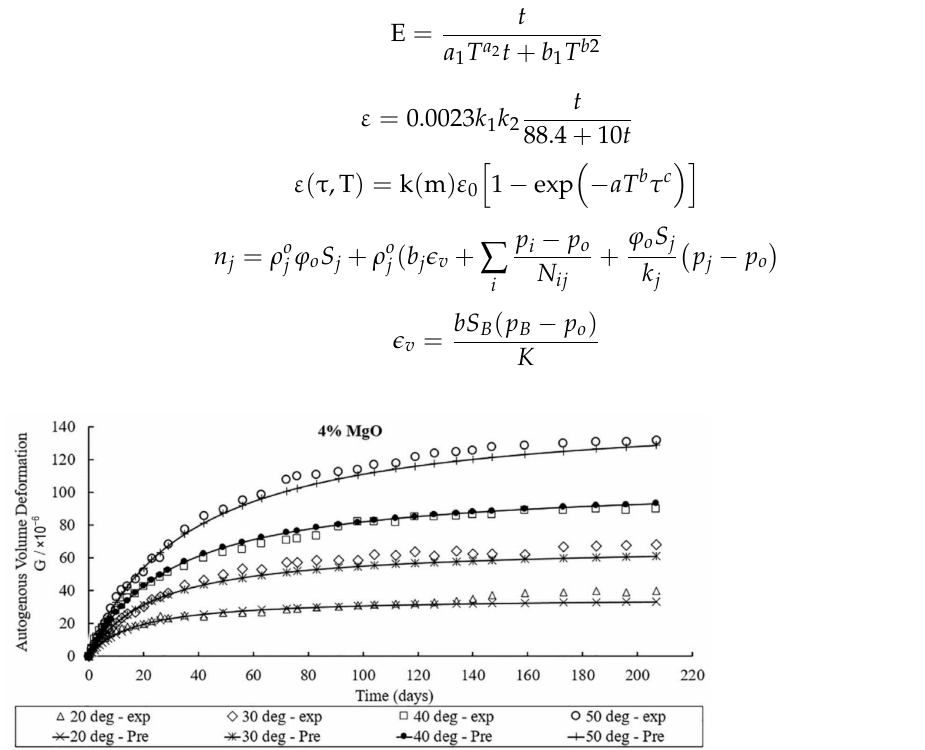
Figure 10. Deformation curve of specimen mixed with 4% MgO content in hyperbolic model under different curing temperature (T) and time (t) conditions (reprinted with permission from Ref. [62], 2019, Elsevier).